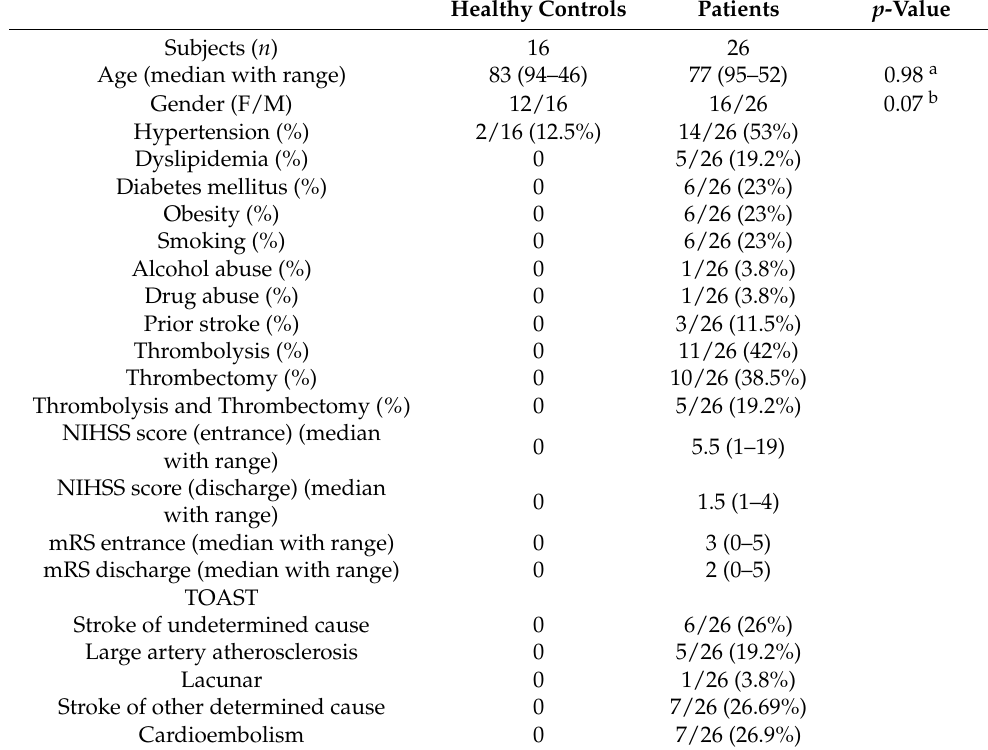
Table 1. Demographic and clinical